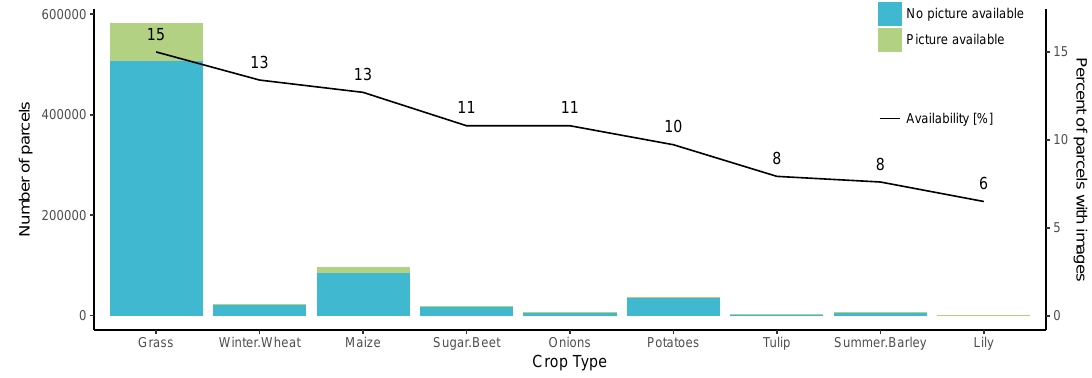
Figure 11. Number of parcels observed and not observed at least once in 2017 per crop group. The crop groups are ordered by the proportion of parcels having at least one picture in 2017 to the total number of parcels